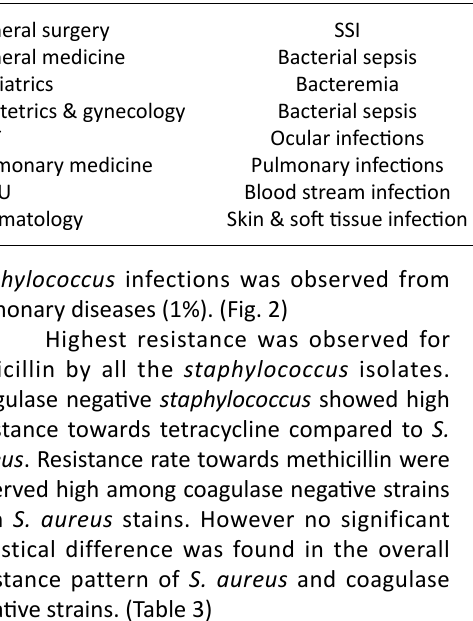
Table 2. Clinical spectrums of Staphylococcus infections according to departments Department